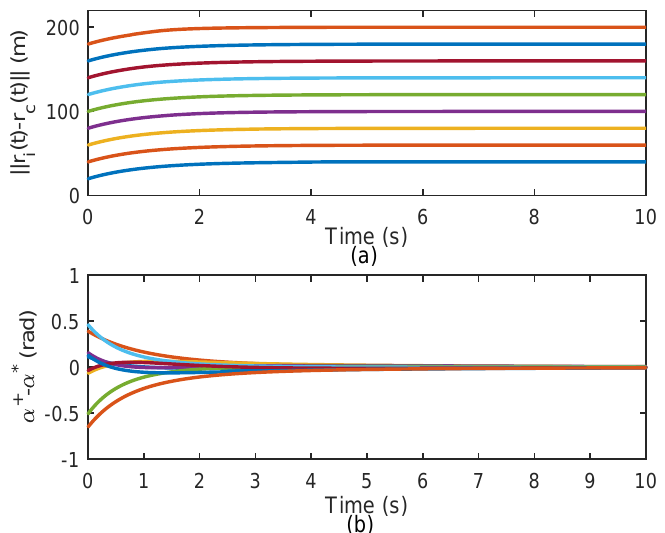
Figure 7. Simulation results of the non-uniform and non-circular formation when k r = 1 and k θ = 1: ( a ) Evolution of (cid:107) r i ( t ) − r c (cid:107) for i = 1,2,..., N on the plane at t ∈ ( 0,10 ] . ( b ) Evolution of (cid:107) α + − α ∗ (cid:107) for i = 1,2,..., N on the plane at t ∈ ( 0,10 ]